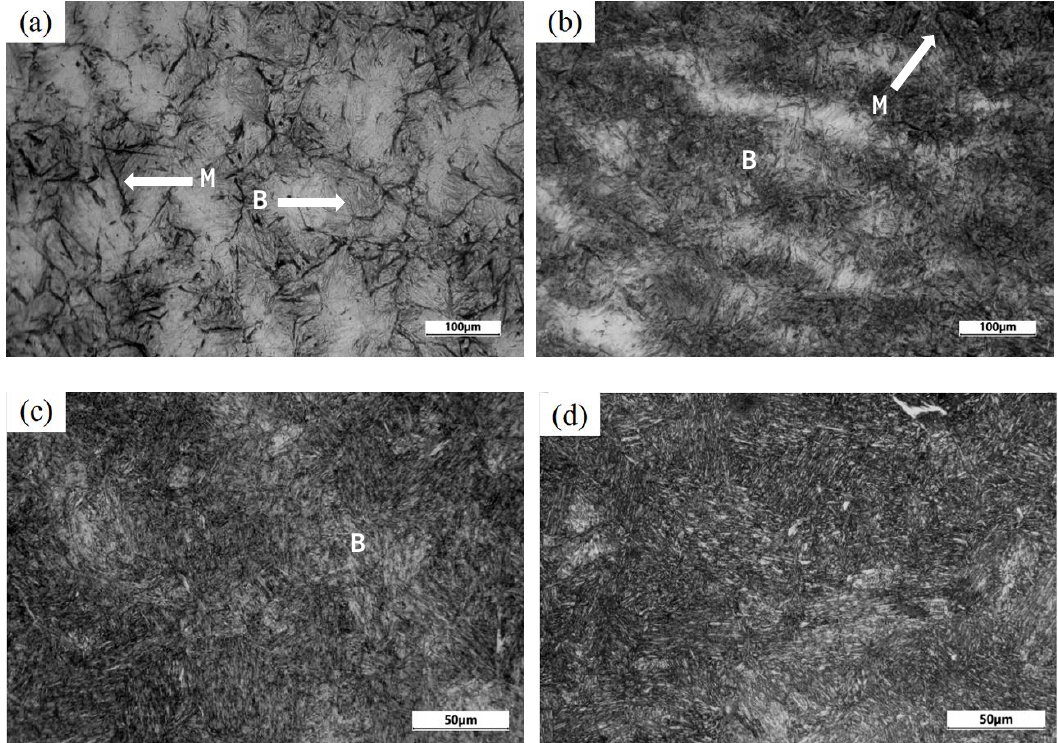
Figure 3. Optical micrographs of experimental steel treated by isothermal transformation at 220 °C for different times: ( a ) 2 h; ( b ) 3 h; ( c ) 7 h; ( d ) 15 h. (M: martensite, B: bainite).